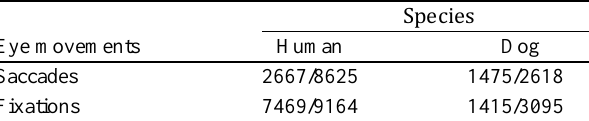
Table 3 Number of saccades and fixations included in the analysis out of total number of data (analyzed data/total